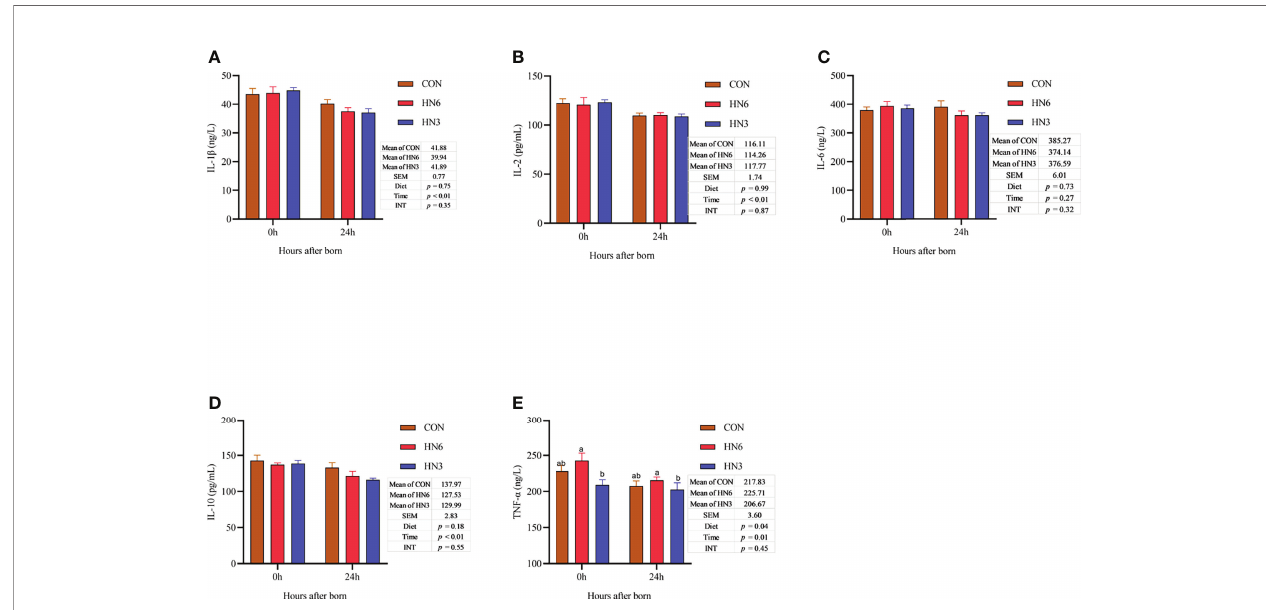
FIGURE 6 | Blood in fl ammatory cytokines in neonatal calves. CON: control treatment (saturated fatty acid source), n = 12. HN3: extruded fl axseed treatment (n-3 PUFA source), n = 12. HN6: extruded soybean treatment (n-6 PUFA source), n = 13. SEM, standard error of the mean; Diet, diet treatment effect; Time, the calving time effect; INT, the interaction effect between diet effect and time effect. IL, interleukin; TNF- a , tumor necrosis factor a . (A – E) : the different blood in fl ammatory cytokines in neonatal calves. Values in the same sampling time point between treatments denoted by different superscript lowercase letters indicate signi fi cant differences ( p < 0.05), whereas those denoted by the same letters or no letters are not signi fi cantly different ( p >